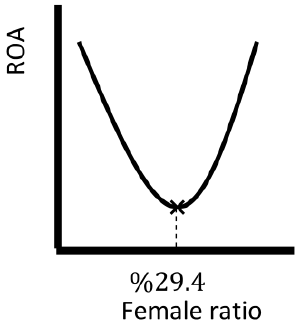
Figure 2. The critical female ratio in the full sample with respect to ROA.